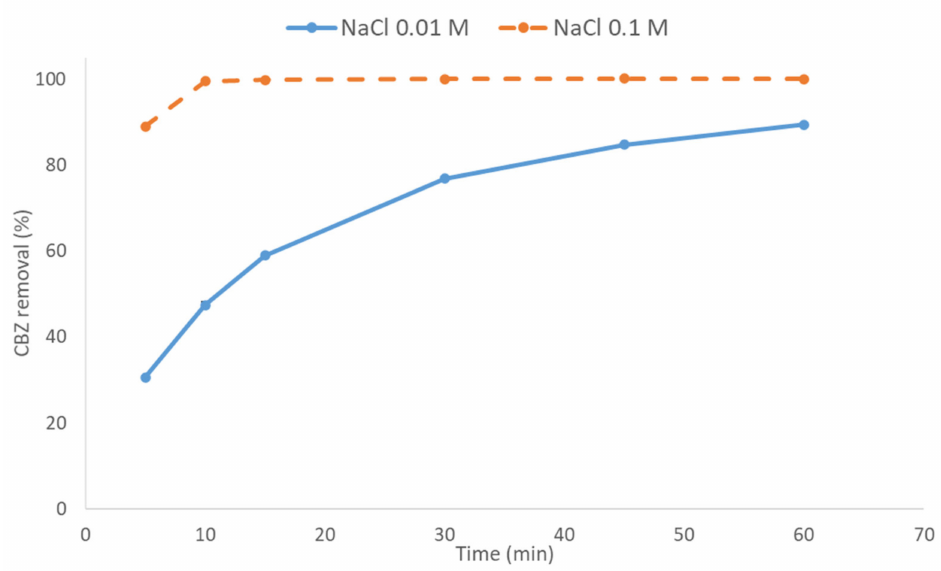
Figure 3. Effect of NaCl concentration on the removal of CBZ from aqueous solutions (operational conditions: j = 6.67 mA/cm 2 ; interelectrode distance = 3.5 cm; CBZi = 10 mg/L; pH = 5; reaction time = 60 min; cathode = STS; anode =